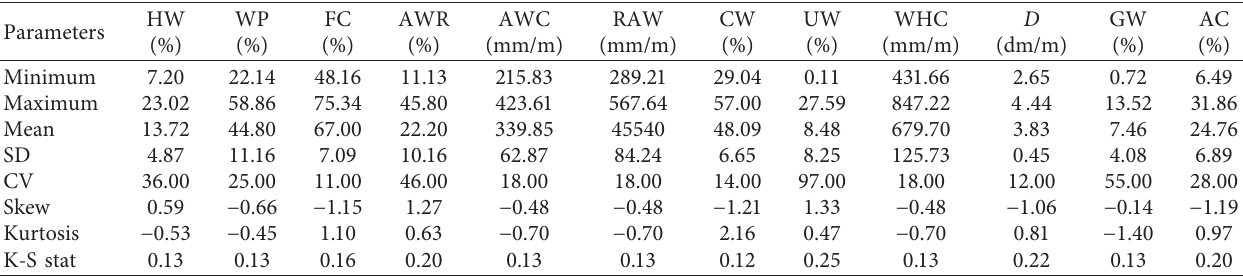
Table 4: Summary statistics of the soil moisture characteristics in the Bamenda wetlands ( n � 20).